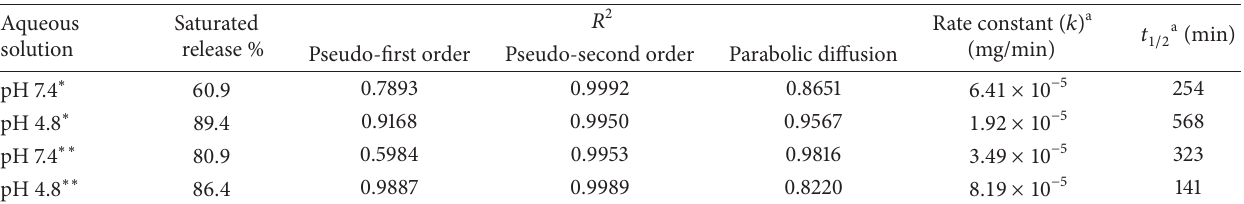
Table 2: Correlation coefficient, rate constant, and half-time obtained by fitting the data of the release of GA from FPEGG and FPVAG nanocomposites into phosphate buffered solutions at pH 4.8 and 7.4.